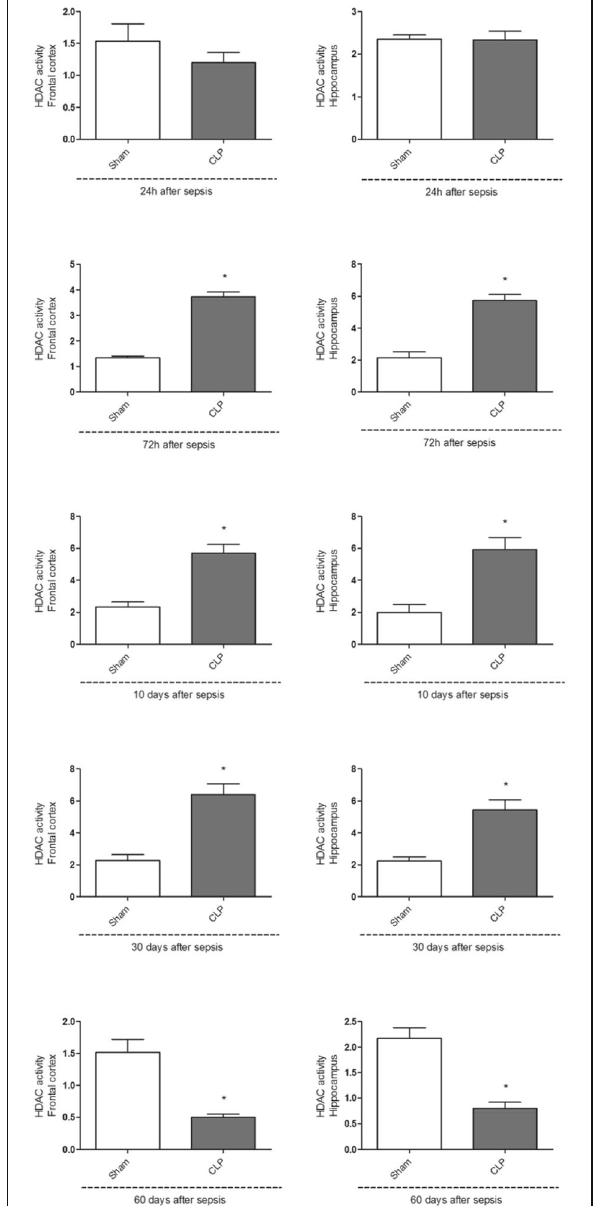
Fig. 2 (abstract P2). See text for description